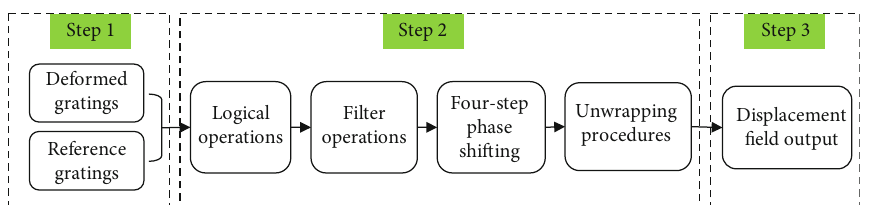
Figure 2: Flow chart of digital image processing.